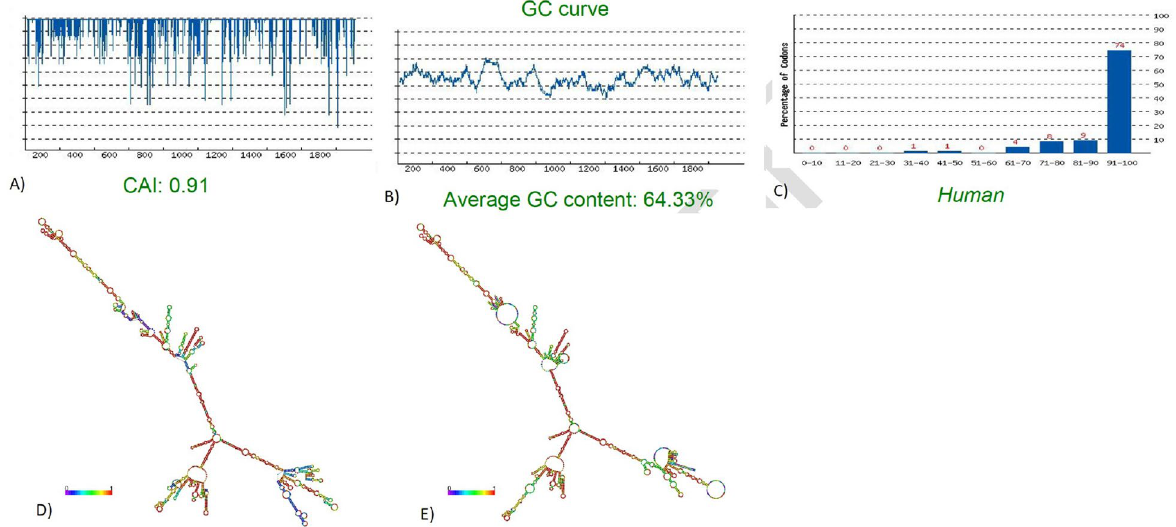
Figure 4. Codon optimization and mRNA vaccine structure prediction: ( A ) CAI value ( B ) GC% ( C ) CFD value ( D ) Optimal secondary structure ( E ) Centroid secondary structure of the vaccine mRNA retrieved using RNAfold Webserver (http:// rna. tbi. univie. ac. at/ cgi- bin/ RNAWe bSuite/ RNAfo ld.